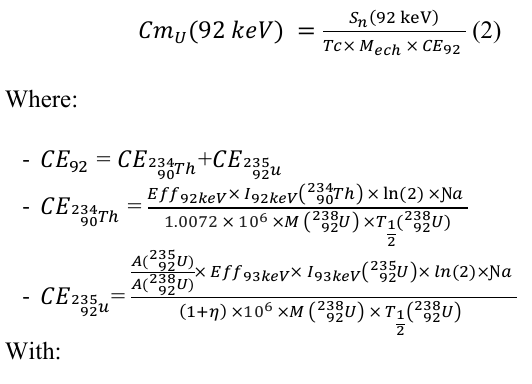
200 keV photon is shown in Fig. 2.